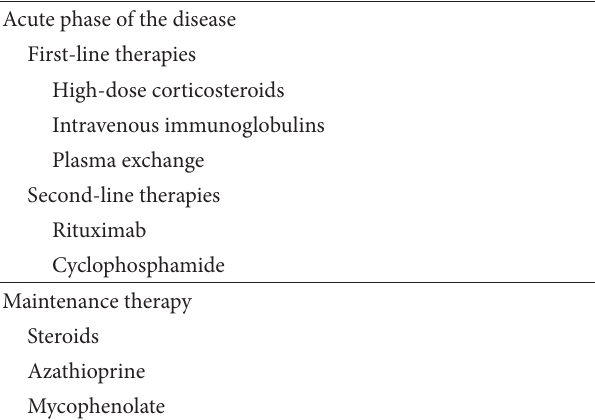
Table 5: Immunotherapies for limbic